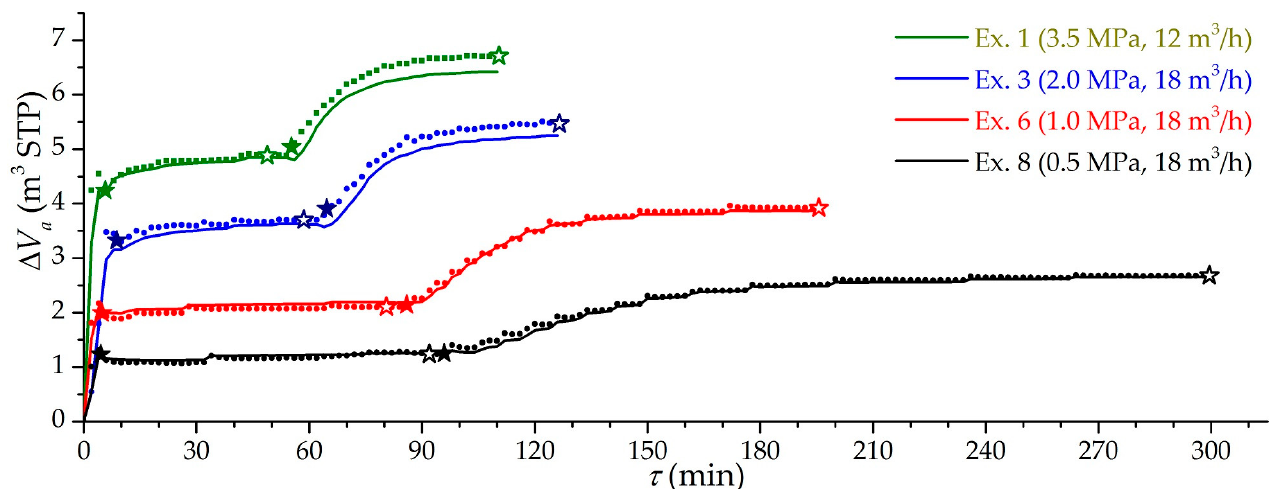
Figure 5. Time dependence of the effective charging capacity at different modes (the number of the experiment is indicated) at isothermal (stage 1) and low-temperature charging (stage 2). Lines are theoretical values, dots are experimental values, solid “stars” are the beginning of circulating charging, and open “stars” are the end of circulating charging.